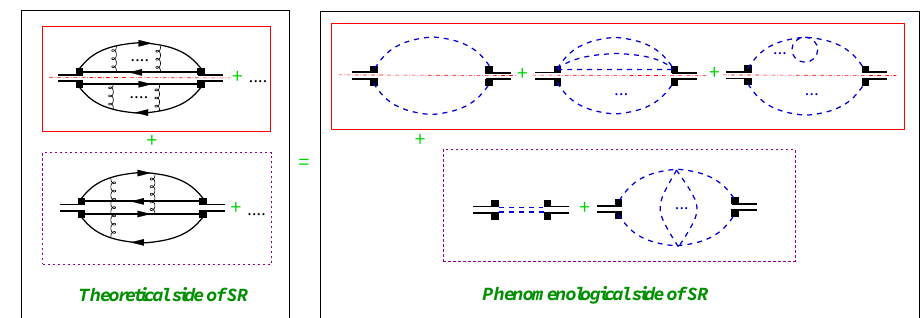
Figure 2. Flavour- preserving two-tetraquark correlation function [6, 9], disintegrable into (top row) two ordinary -meson QCD sum rules and (bottom row) a QCD sum rule possibly supporting tetraquark poles.